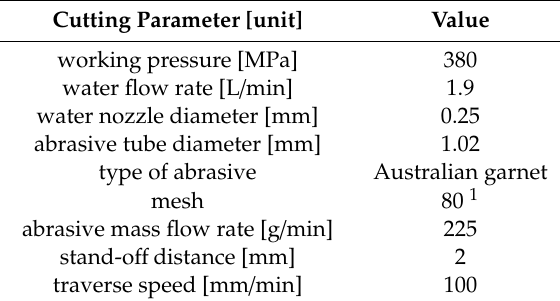
Table 3. AWJ cutting